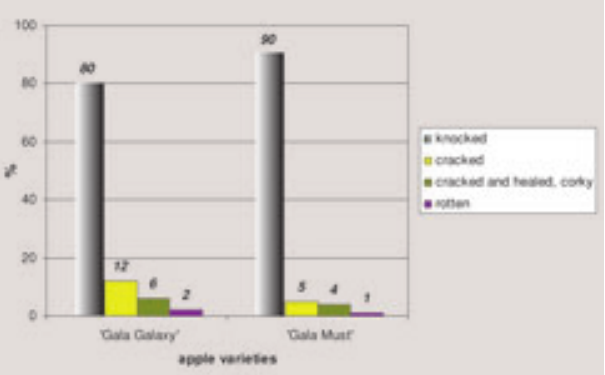
Figure 6. Typology of the damage caused by hail on apple fruits ( Debrecen- Pallag, 2011)